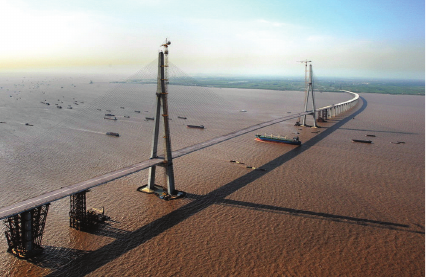
Figure 1: View of Sutong cable-stayed bridge